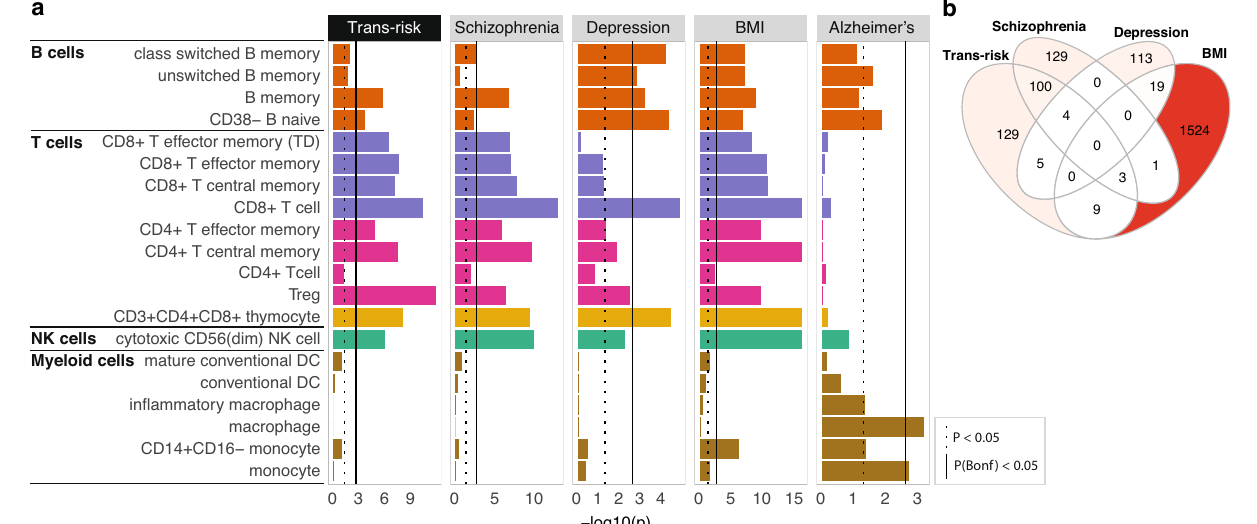
Fig. 3 | Trans- and cis-diagnostic risk variant enrichment at histone-acetylated marks on adult immune cells in the BLUEPRINT dataset. a Bar plots show enrichment of genetic risk for each disorder at active promoters/enhancers (H3K27acmarks)inunstimulated,sortedimmunecells.CHEERSwasusedtodetect enrichment of risk loci at cell-type speci fi c H3K27ac peaks (see Methods). P -values are reported from a discrete uniform distribution (one-sided tests). The dotted black line marks the nominal signi fi cance threshold, P <0.05; the solid black line